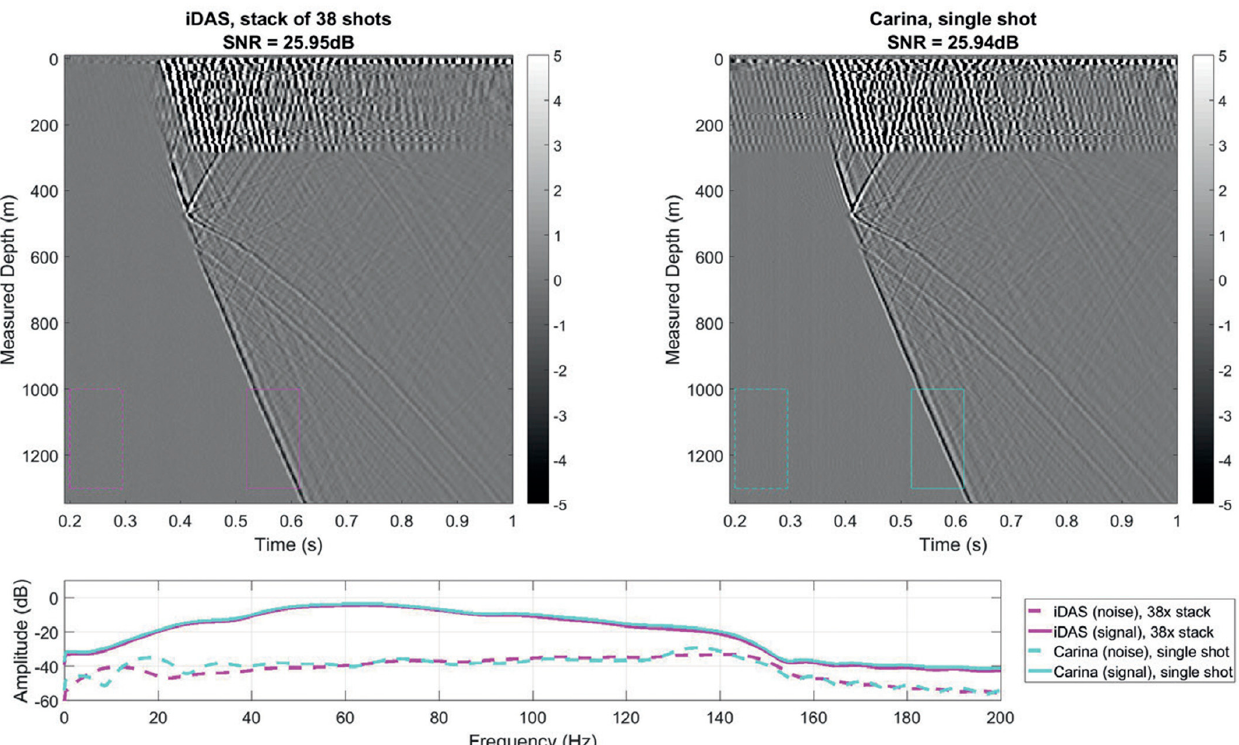
Figure 4. DAS data quality acquired with a modern interrogator, using regular and engineered fiber. For a regular fiber ( left ), a stack of 38 shots is required to obtain the SNR of a single shot recorded with an engineered signal ( right ). Recorded amplitude as a function of frequency, using both fibers, is at the bottom. Figure from Naldrett et al. (2020), First Break.